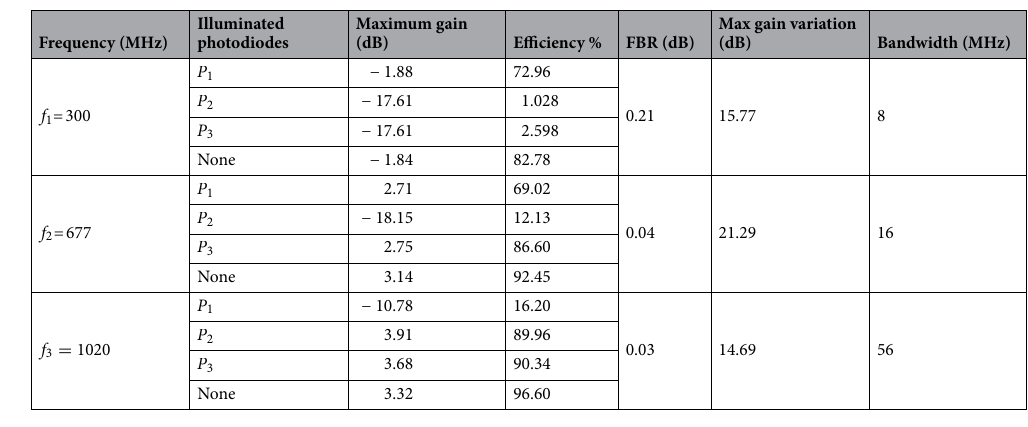
Table 4. Simulated variation in radiation performance under different illumination